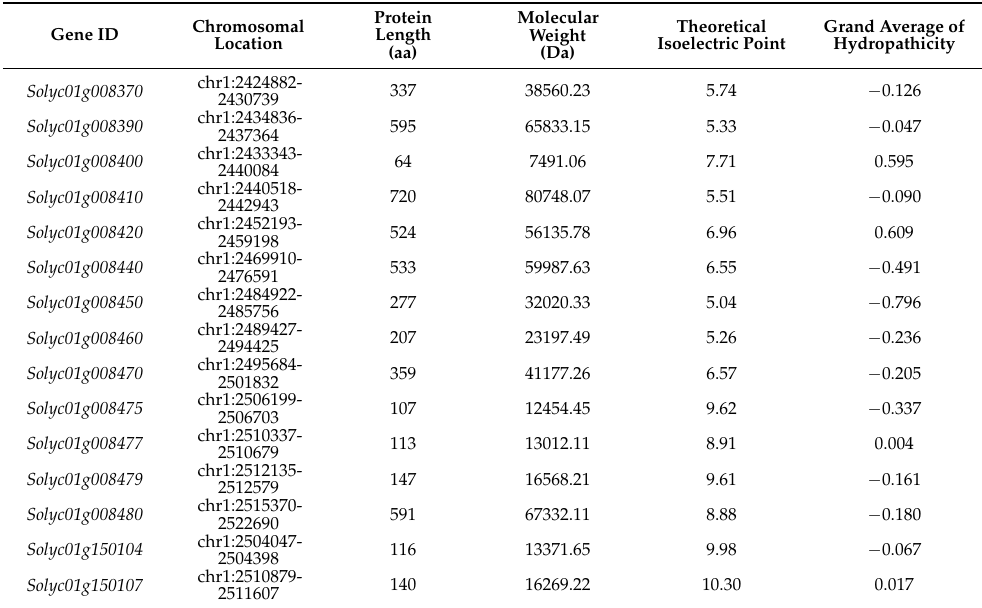
Table 3. Analysis of the genes and predicted amino acids sequences within 50 kb upstream and downstream of TGS377 in tomato.